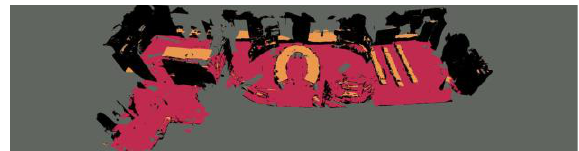
Figure 2: Time focused visualization. From left to right: > 5 minutes = orange; 3-5 minutes = yellow; 0-3 minutes = grey